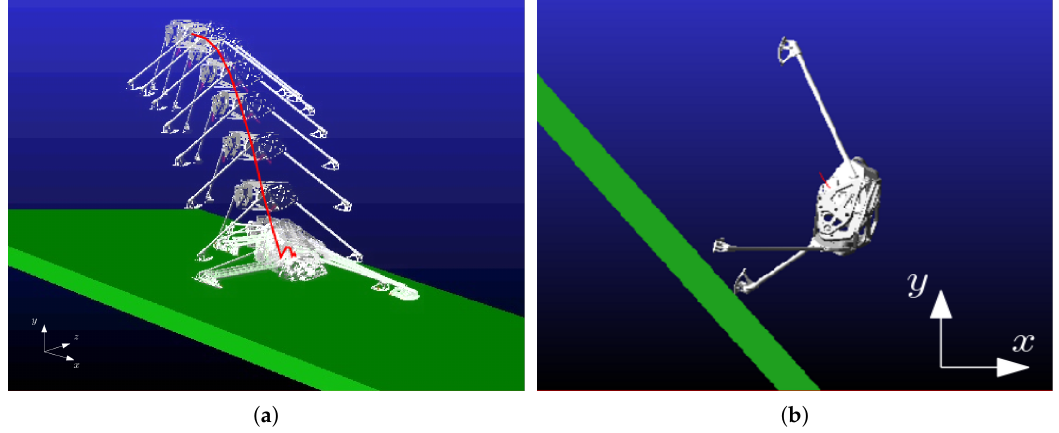
Figure 10. ( a ) A time-series representation of the simulation for the lander MBS soft-landing conducted on an inclined surface; ( b ) the lander MBS toppling at the landing critical angle β cr